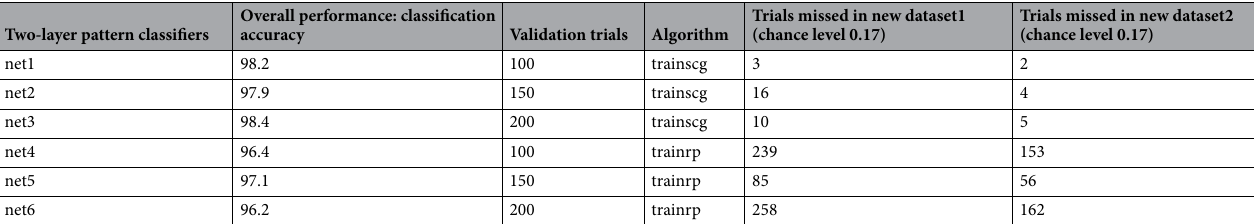
Table 1. Overall performance accuracy, validation trials, algorithms and trials which could not be categorized in the two new datasets for different two-layer feedforward networks. The networks were composed of 260 neurons in the first layer and 156 in the second layer. Net1 has finally been selected. The behavioral categories were selected against the threshold of p = 0.17, meaning that if the indicated probability of a behavioral category exceeded this threshold, this category was selected. This specific threshold was selected because of the chance level of selecting a category against 6 possible categories was p = 0.1667 and rounded upto p =